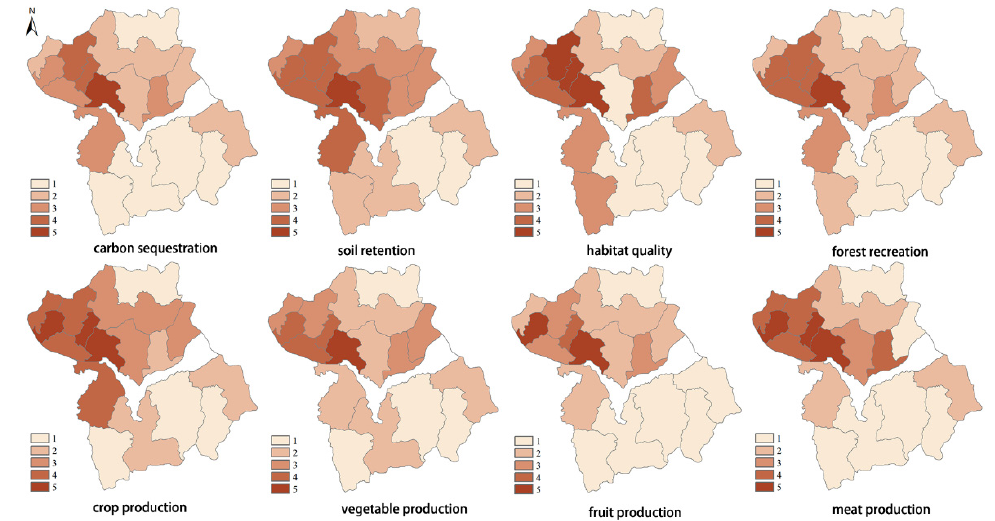
Figure 6. Spatial distribution of ecosystem services demand in Huailai